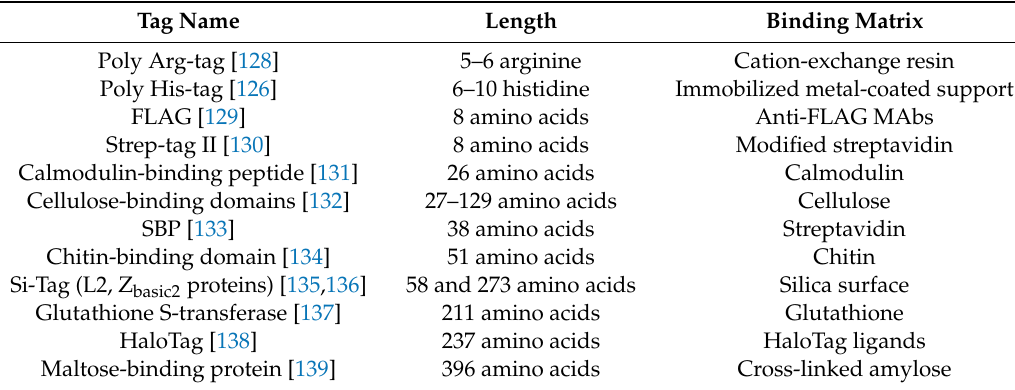
Table 1. A ffi nity tags for protein purification (protein